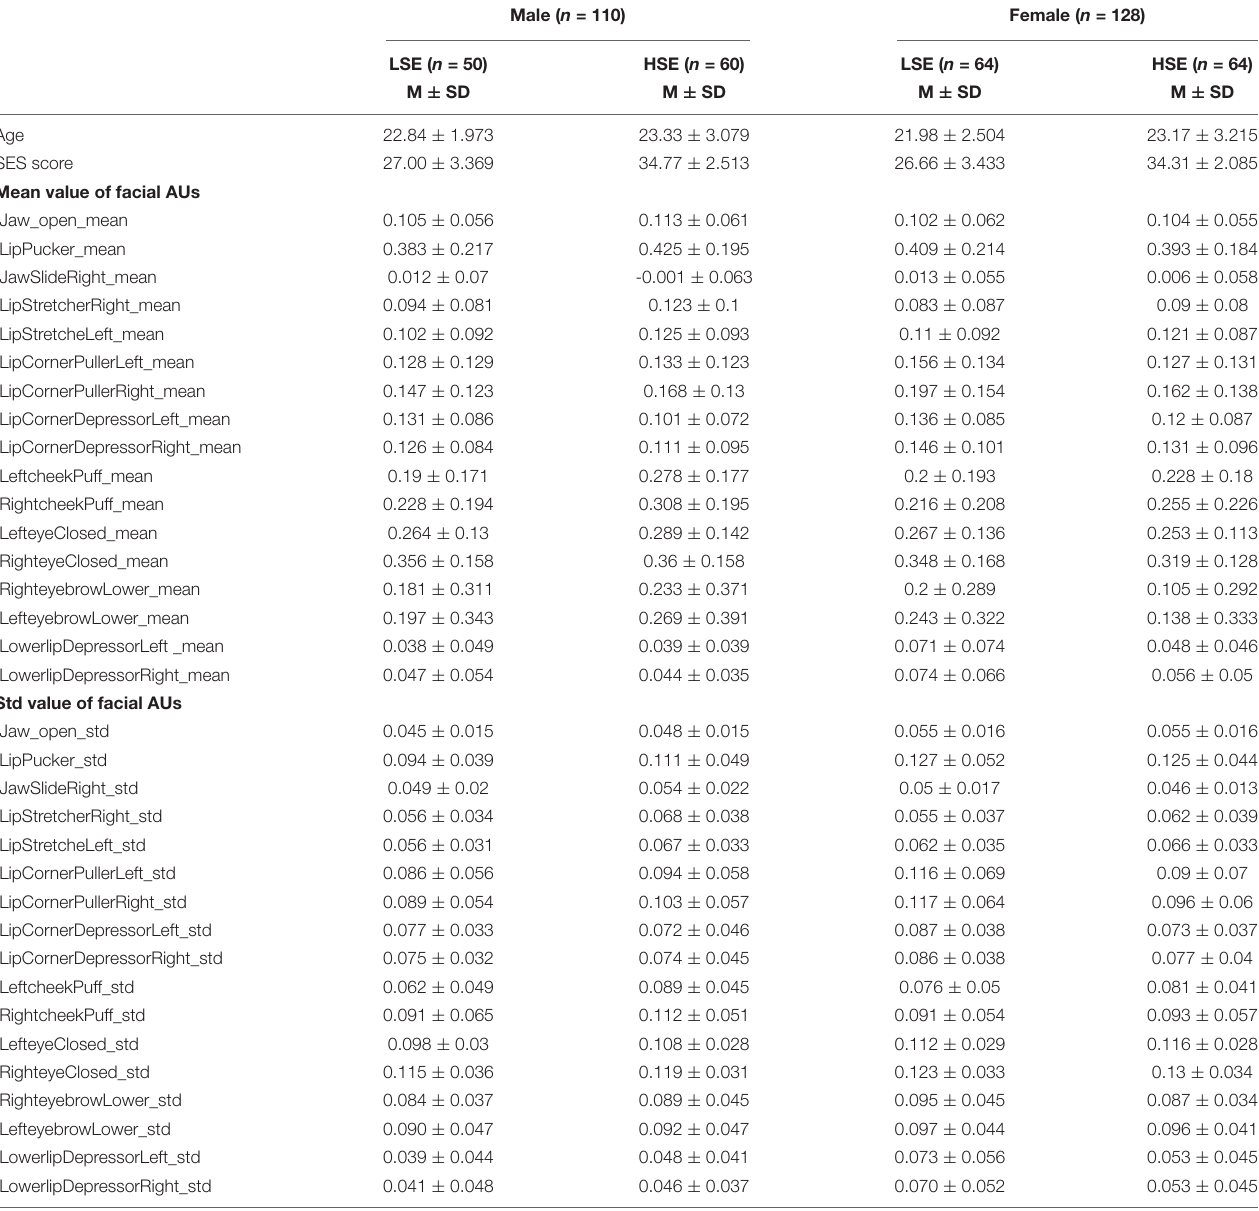
TABLE 2 | Participants